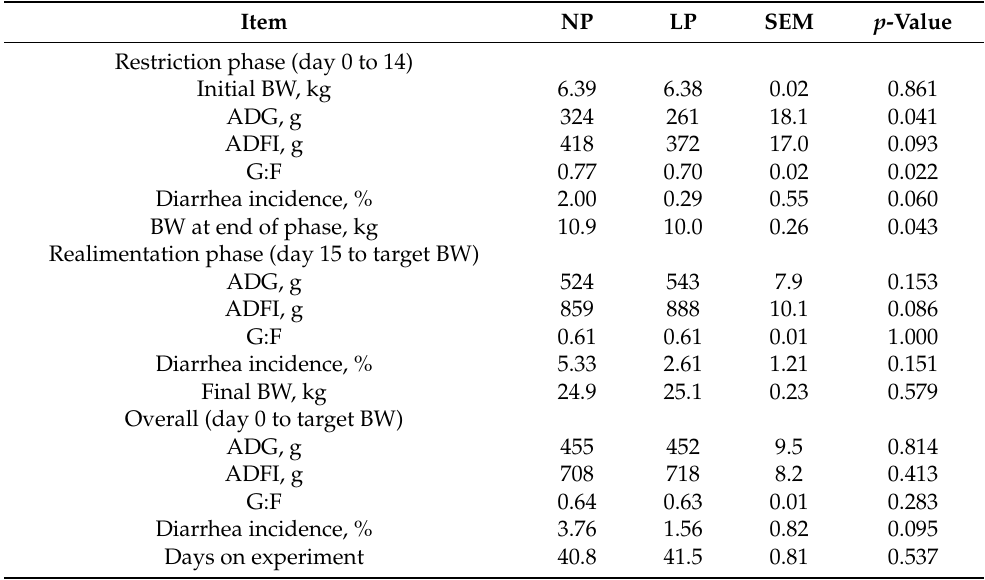
Table 2. Effects of protein restriction and realimentation on the growth performance of piglets 1 .